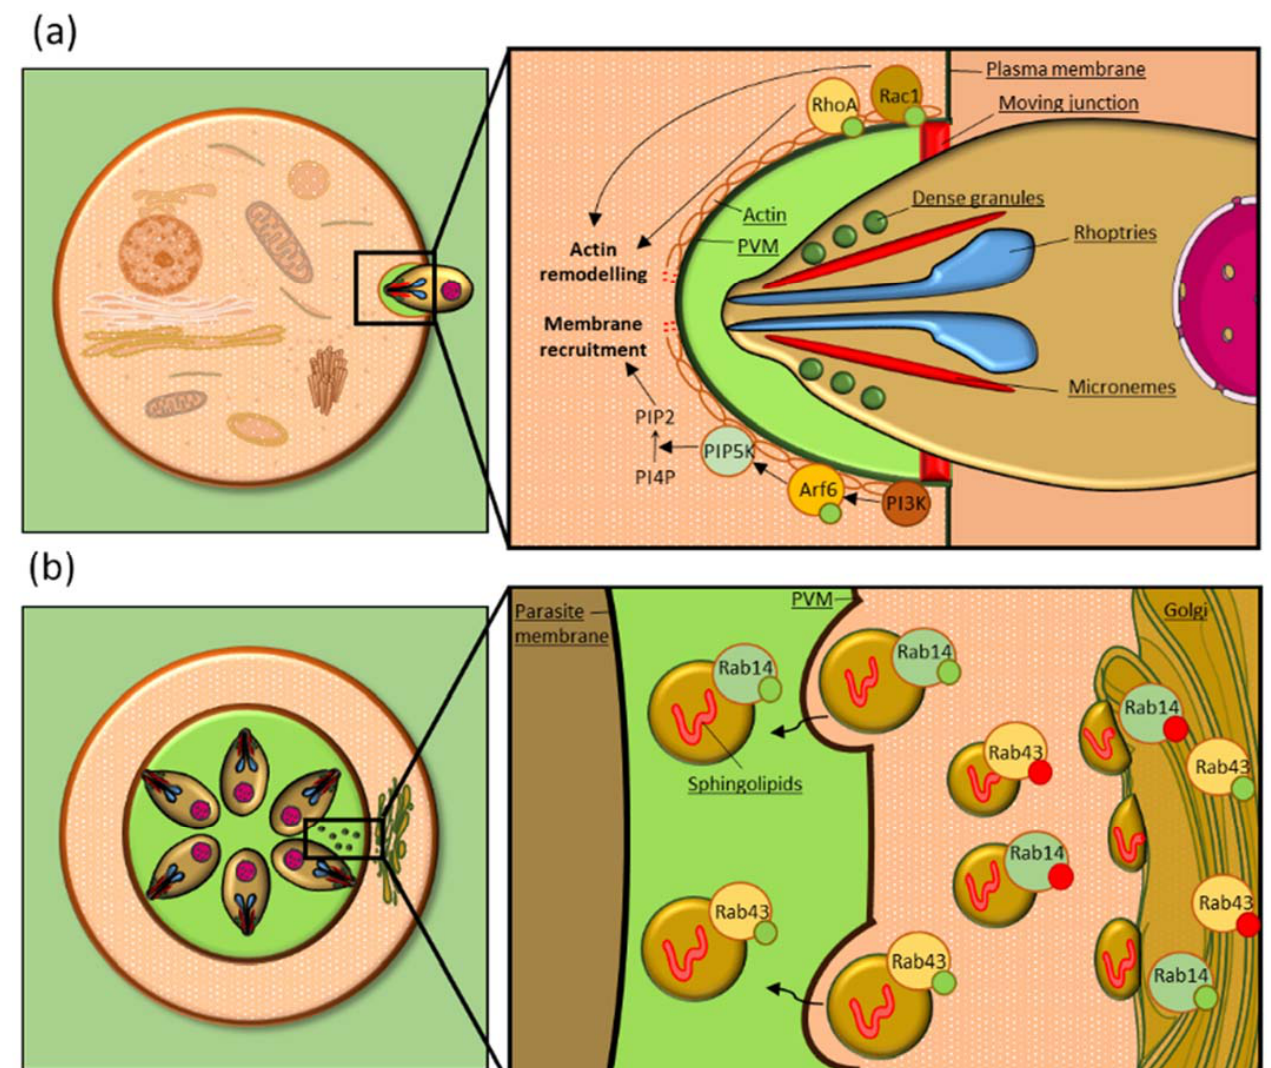
Figure 1. Toxoplasma gondii manipulates Rho, Arf and Rab GTPases . ( a ) Schematic of an invading stage of T. gondii . Rac1 and RhoA are recruited to the site of parasite entry and their activity is required for actin cytoskeleton remodeling during invasion. Moreover, Arf6 is recruited to the site of parasite entry and activated by PI3-kinase. Arf6 activation triggers PIP5-kinase that produces PIP2 from PI4P, resulting in actin remodeling and membrane recruitment. ( b ) Schematic representing replicating T. gondii parasites. During their intracellular development, T. gondii parasites scavenge sphingolipids from host Golgi-derived vesicles bound to Rab14 and Rab43. Only vesicles bound to active Rab GTPases are delivered to the PV. PVM: parasitophorous vacuole membrane. Green circles represent GTP and red circles GDP. Figure created with the support of https://smart.ser- vier.com/ (accessed on the 5 May 2022).